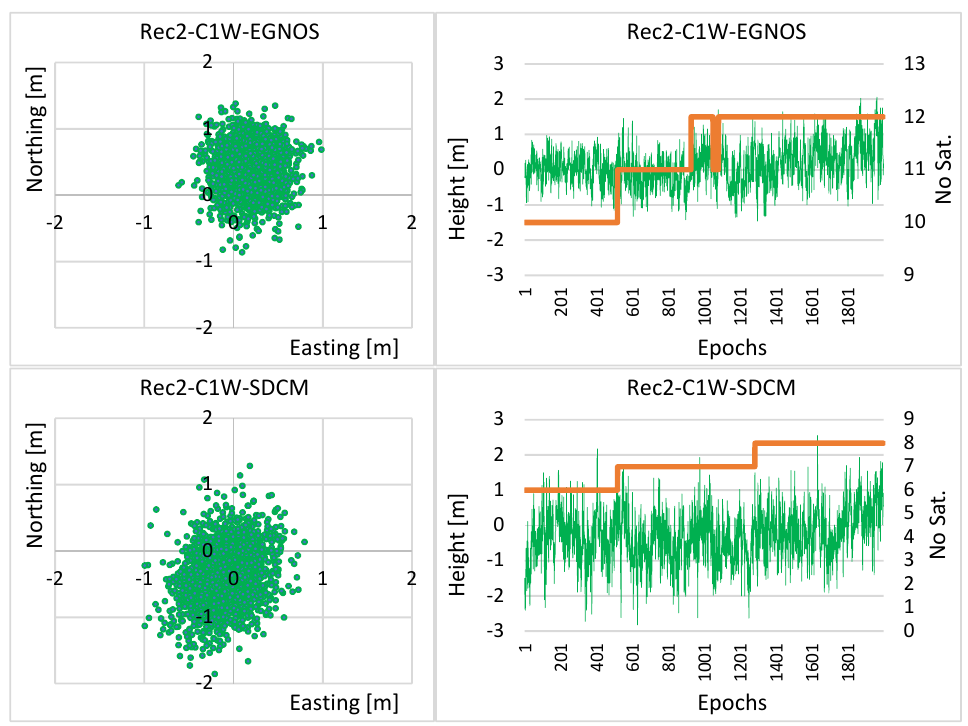
Figure 7. Real errors of horizontal and vertical coordinates of SBAS positioning based on C1W code, for the receiver Rec1 with EGNOS or SDCM corrections (Step II, see Figure 1).